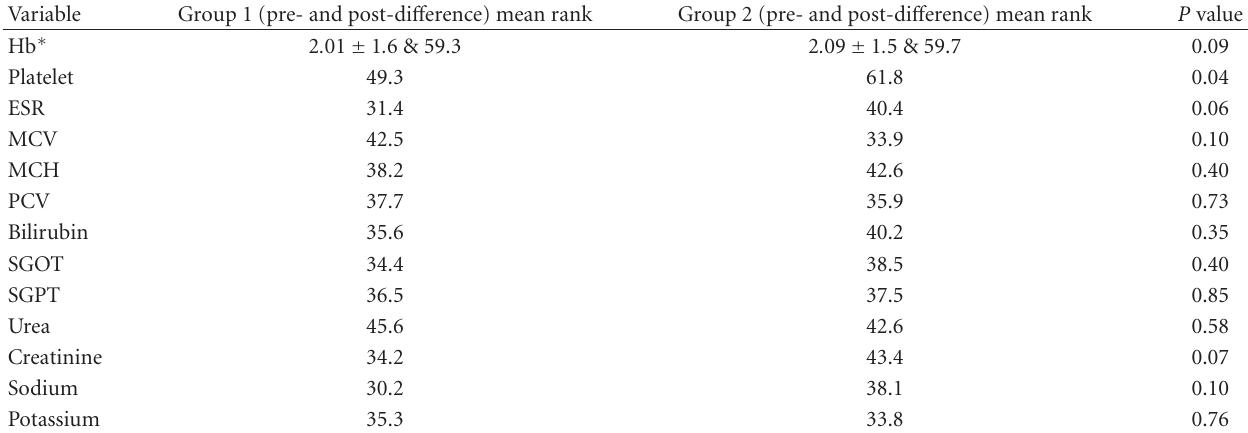
Table 4: Nonparametric analysis of the di ff erence in hematological parameters within and between